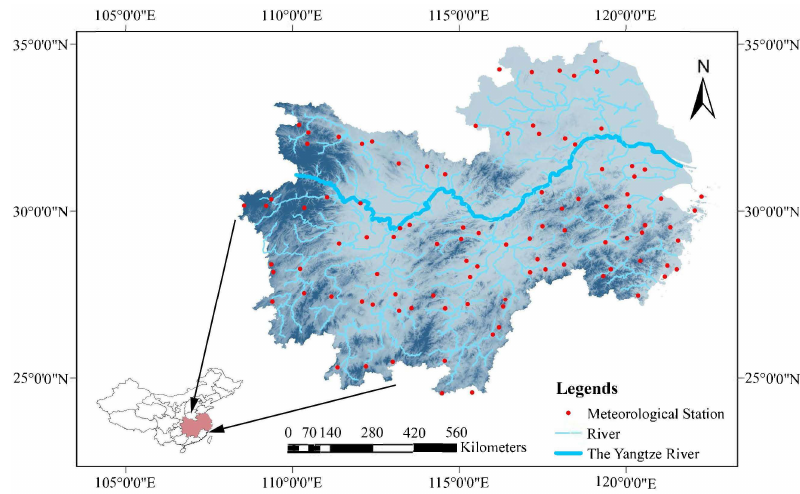
Figure 2. Location of the catchments and 99 meteorological stations.